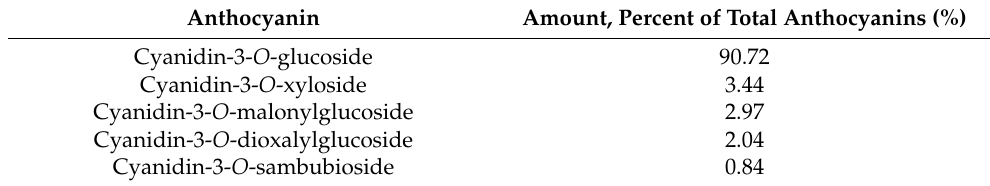
Table 8. Anthocyanin composition of blackberry ( Rubus fruticosus)